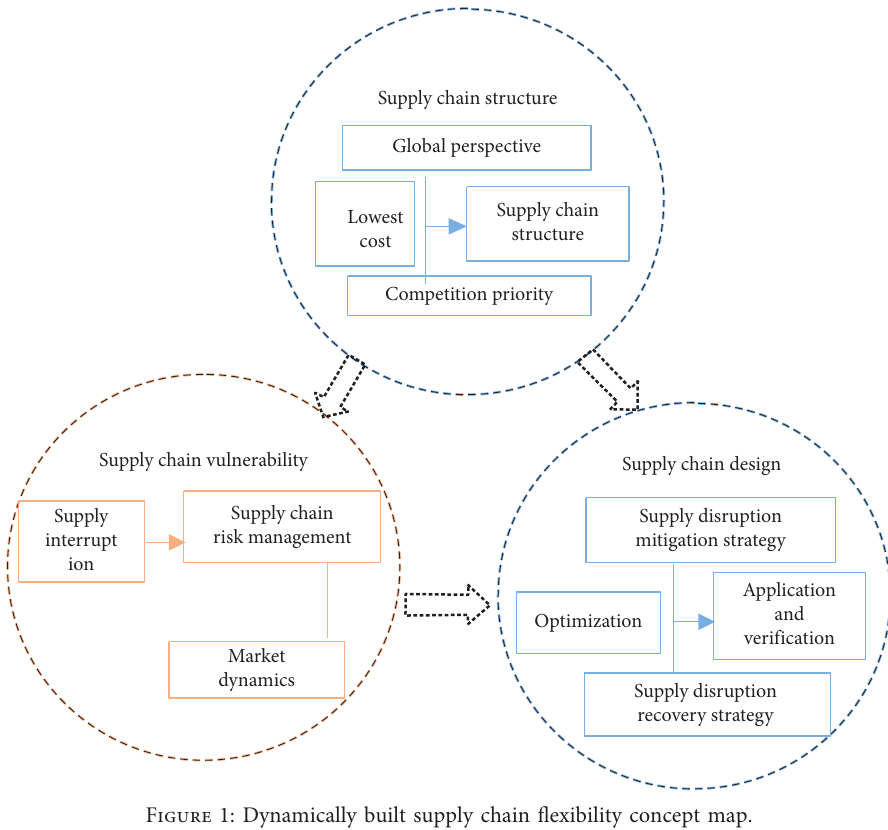
Figure 1: Dynamically built supply chain flexibility concept map.